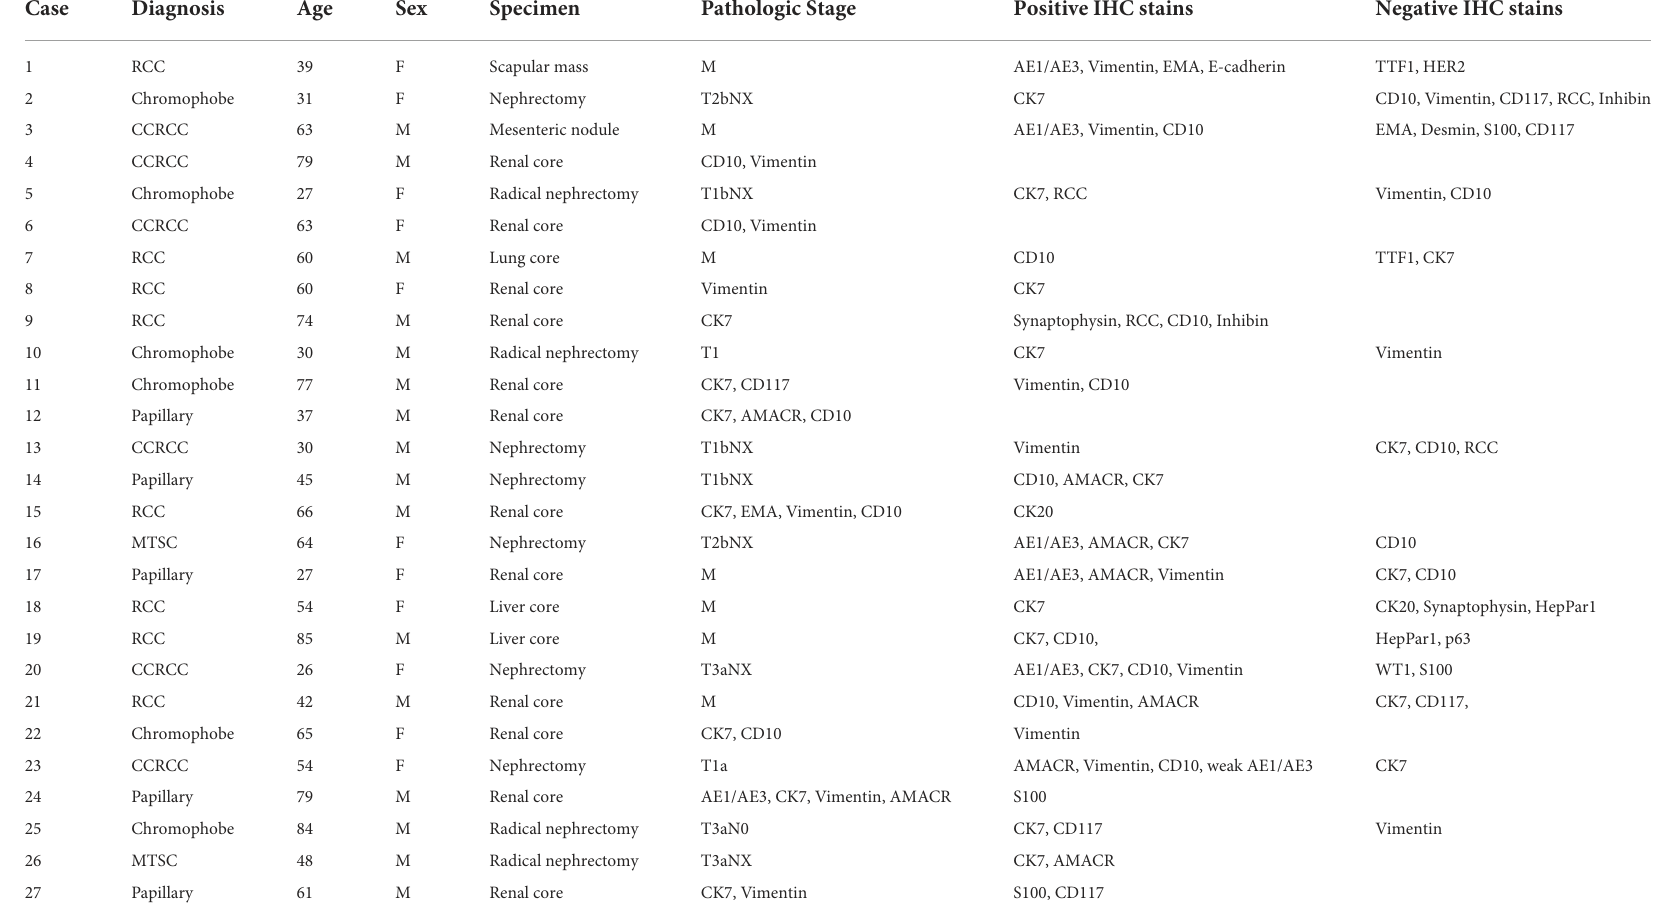
TABLE 4 Clinicopathologic characteristics and immunoprofile of renal cell